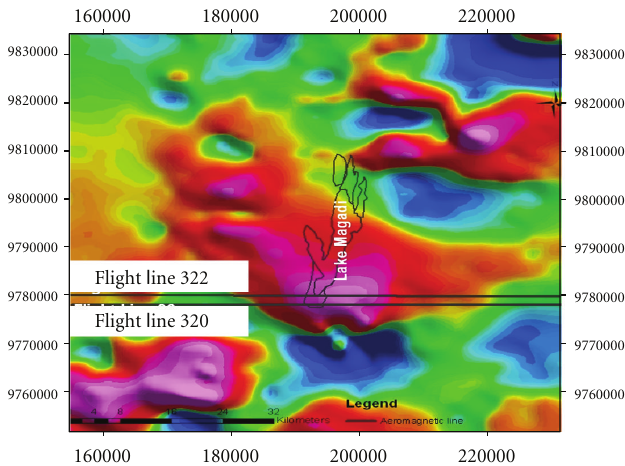
Figure 10: Colour-shaded aeromagnetic total magnetic intensity (TMI) grid data for Lake Magadi area.